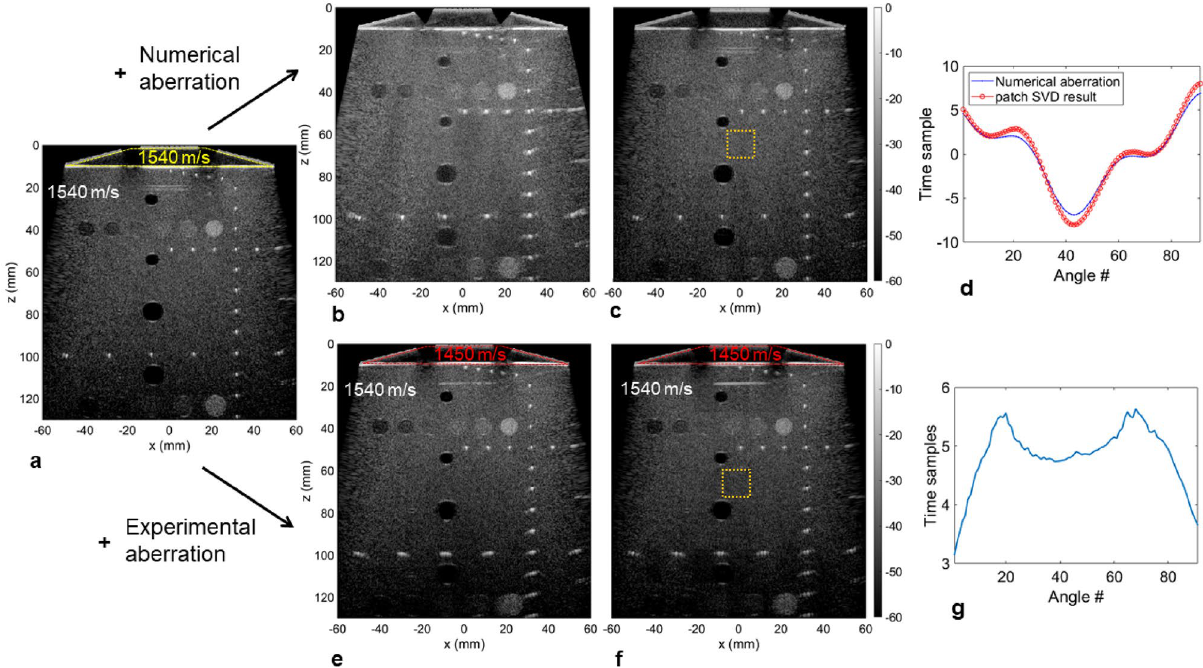
Figure 5. Evaluation of aberration correction on the array assembly with the SVD beamformer on the calibrated commercial phantom (CIRS 054GS). ( a ) Delay-and-sum (DAS) image of the phantom with proper speed of sound matching between the arrays and the top flat surface of the phantom (the yellow trapezoidal contour highlights the agar/glycerol standoff). ( b ) A numerical aberration is applied on the receive data resulting in image degradation. ( c ) The application of the SVD beamformer retrieves the original image. ( d ) Comparison of the aberration estimated from the SVD processing (red) to the numerical aberration applied to the receive data (blue) as a function of the angle number. The isoplanatic patch used for the estimation is indicated by the orange square in ( c ). ( e ) The standoff is replaced with a water/ethanol solution (35/65 volume ratio) reducing the speed of sound to 1450 m/s and degrading the DAS image. ( f ) Image degradation is reduced after applying the SVD beamformer. ( g ) Aberration estimated from the SVD processing as a function of the angle number. The isoplanatic patch used for the estimation is indicated by the square in ( f ). The dynamic range is 60 dB for all